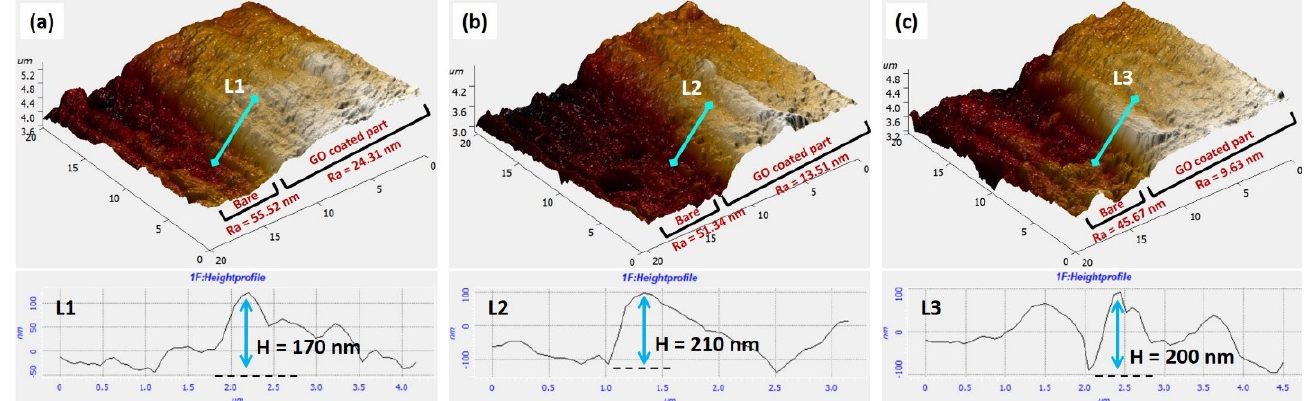
Figure 3. AFM of coating interfaces showing coating thickness along with roughness values for ( a ) EPD-GO-A coating, ( b ) EPD-GO-E coating, and ( c ) EPD-GO-W coating.